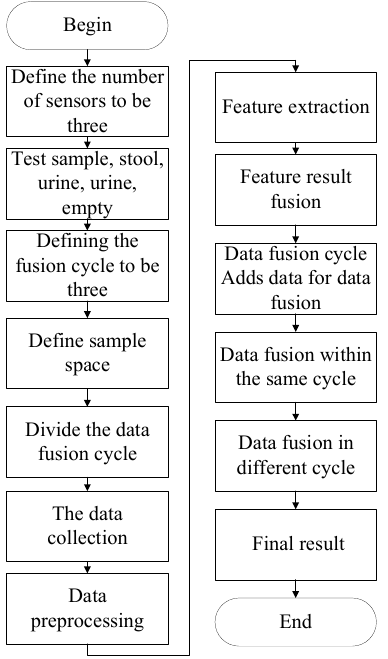
Figure 9. D-S evidence theory model running flowchart.